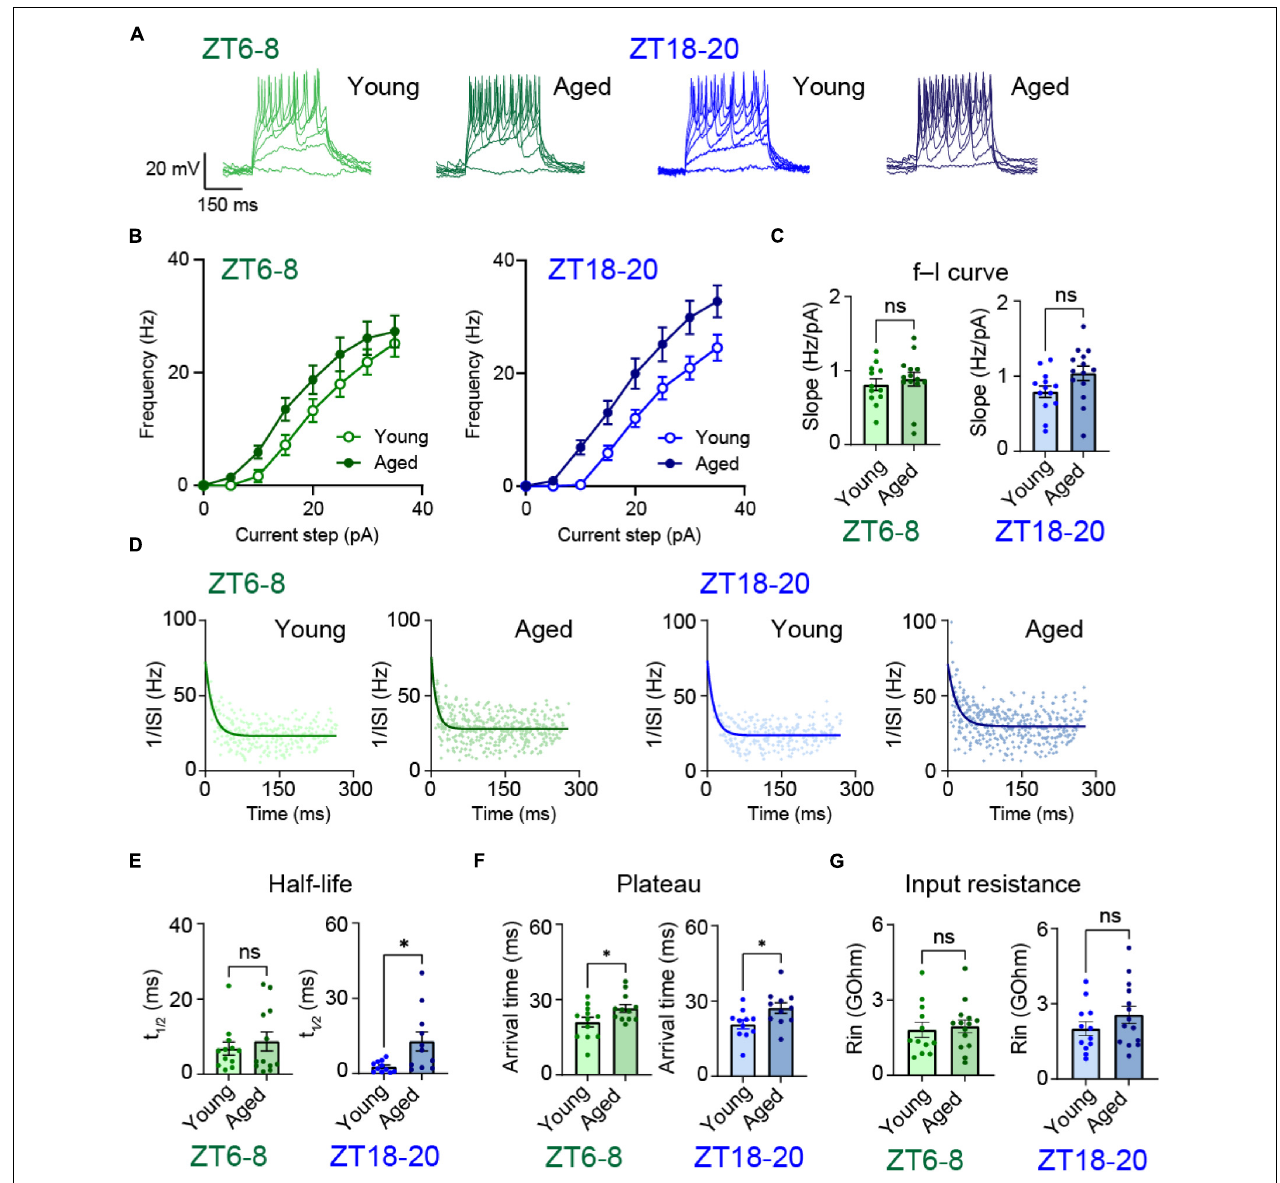
FIGURE 3 | Aging altered membrane potential responses elicited by current injections in DN1p neurons. (A) Representative membrane potential traces of spontaneous firing in young and aged DN1p neurons at ZT6–8 and ZT18–20. (B–E) Mean firing rate vs. injected current (B) , slope factor obtained from linear regression (C) , instantaneous spike frequency vs. occurrence time showing spike frequency adaptation (D) , half-life spike (E) and plateau (F) obtained from curve fitting, and input resistance (G) of young and aged DN1p neurons at ZT6–8 and ZT18–20 (ZT6–8, young: n = 12, aged: n = 14 ZT18–20, young: n = 12, aged: n = 14). ∗ p < 0.05 based on t